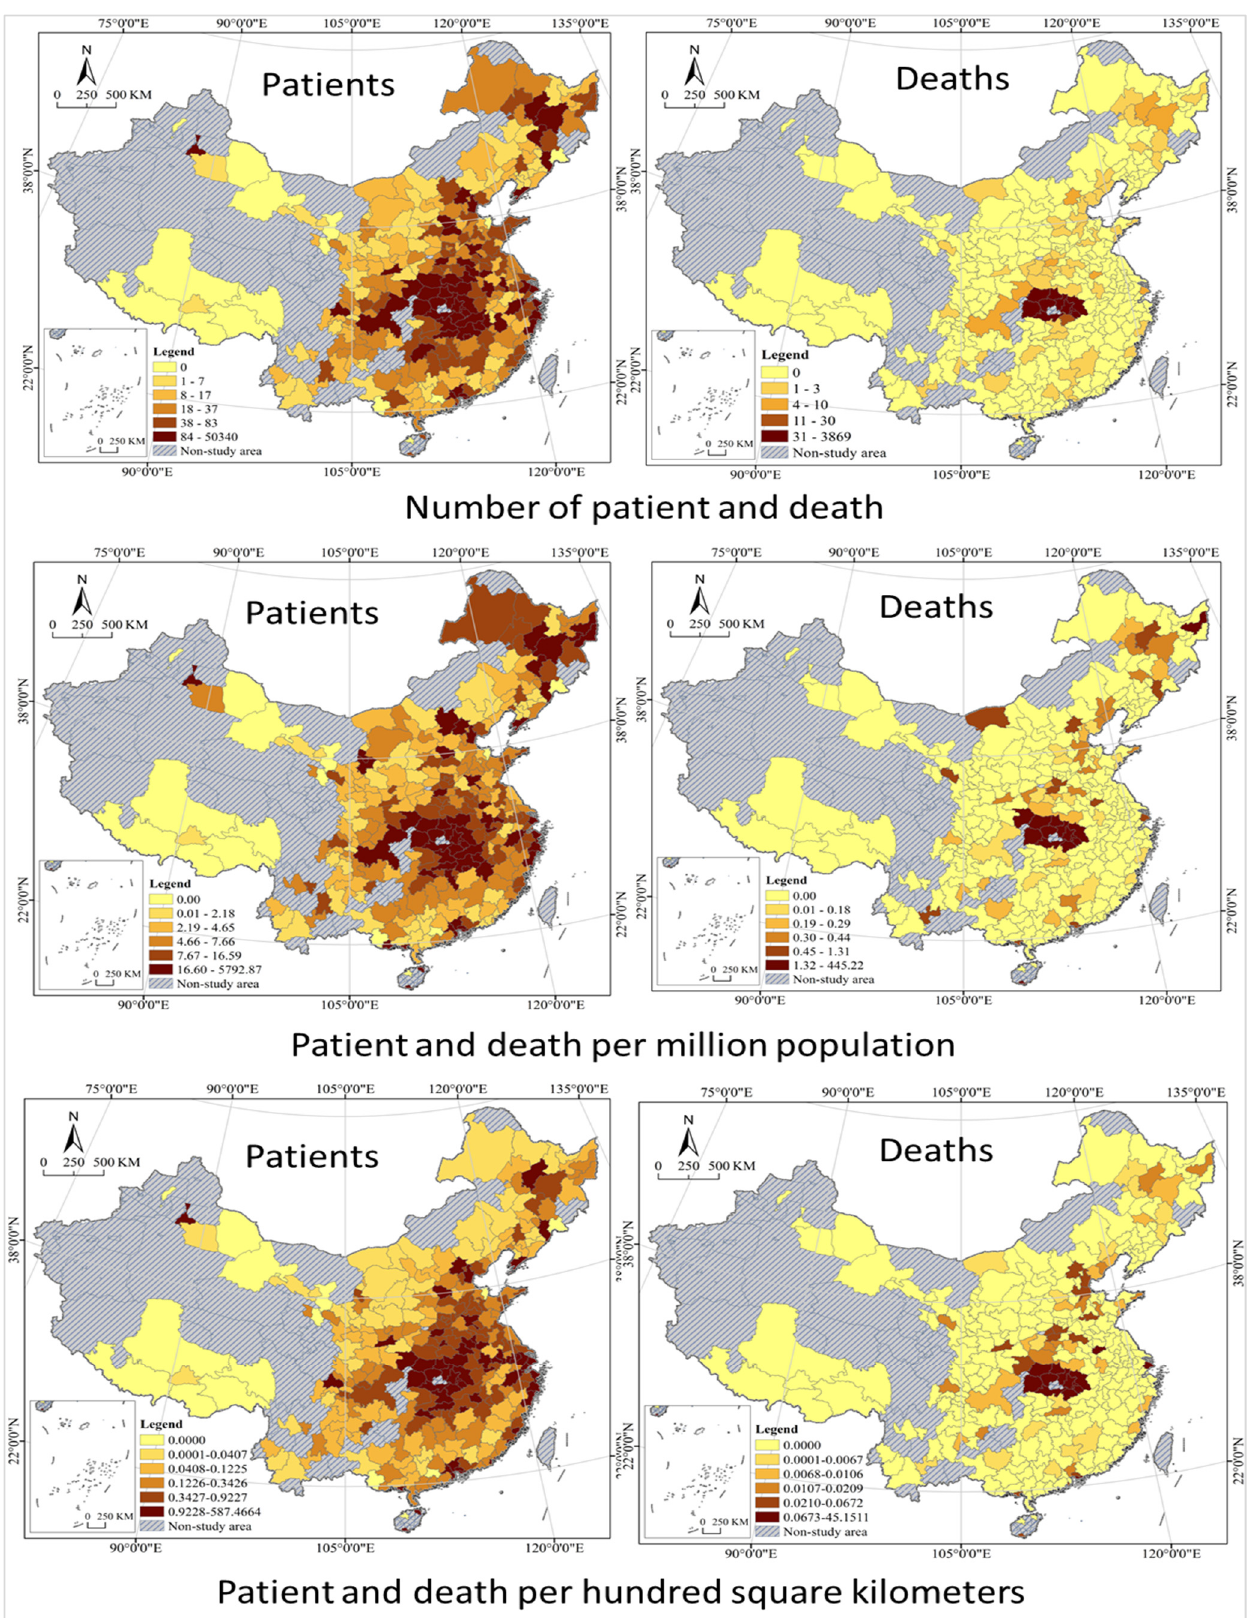
Figure 4. Cluster analysis of COVID-19 in China cities.